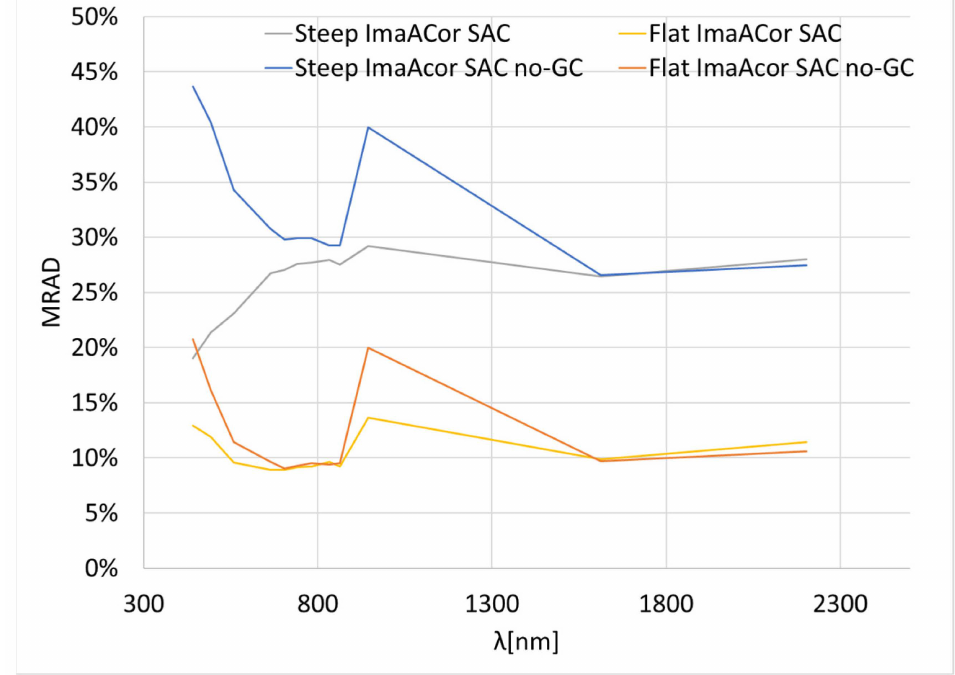
Figure 4. MRAD plots, as a function of wavelength, of ImaACor reflectances obtained from L1 Sentinel 2 data through a SAC procedure applied both including and excluding ground compensation